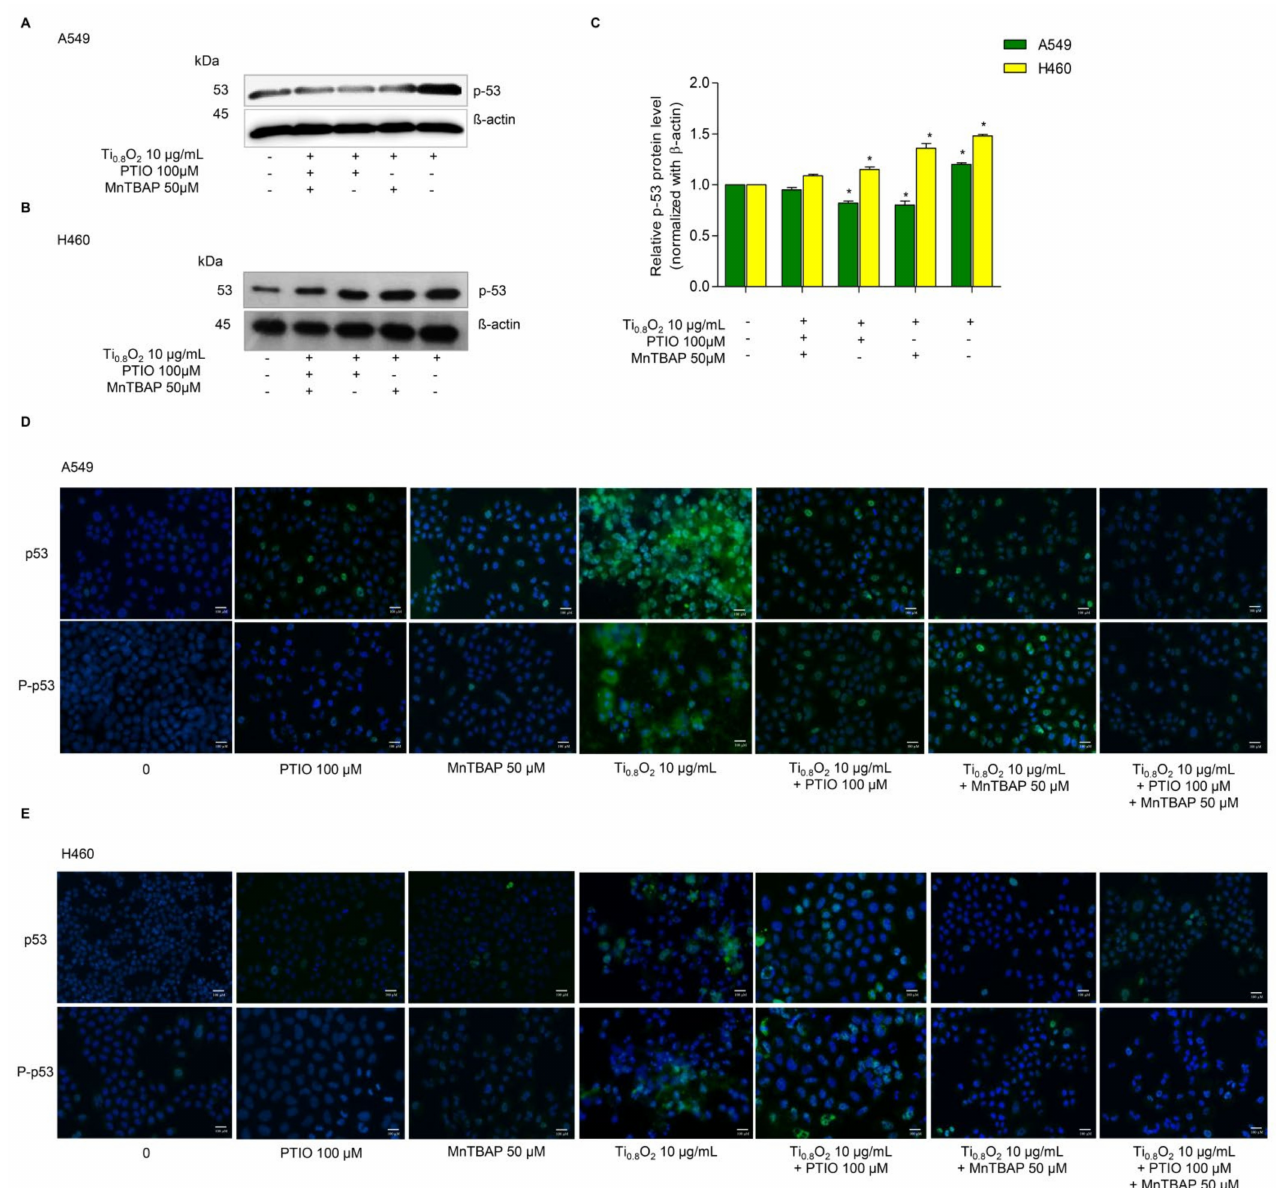
Figure 7. Ti 0.8 O 2 nanosheets associated with apoptosis in A549 and H460 cells via p53 upregulation. ( A , B ) Peroxynitrite- potentiated cell apoptosis through the p53 protein was measured by Western blot analysis; ( C ) blots were reprobed with β -actin to confirm the equal loading of samples. The relative protein levels were calculated by densitometry. Data are shown as the mean ± SEM ( n = 3). * p < 0.05 versus non-treated control. ( D , E ) the expressions of p53 and P-p53 were analyzed by immunofluorescence staining in A549 and H460